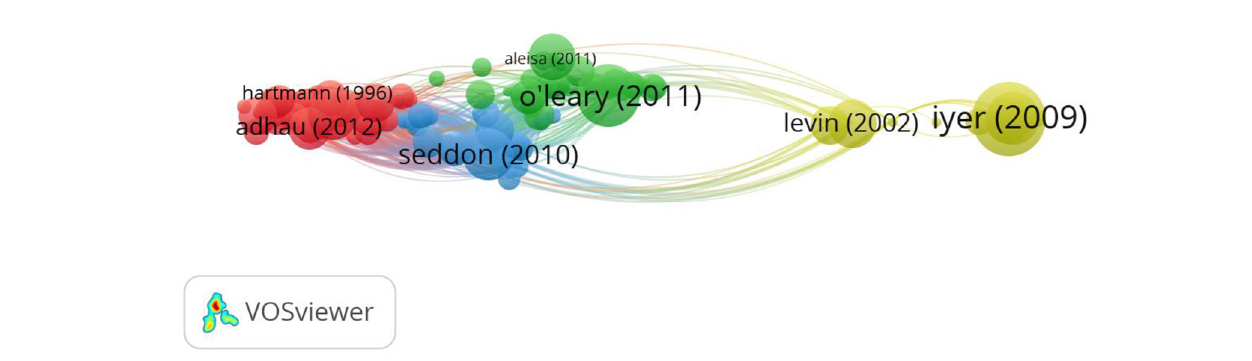
FIGURE5 Bibliographic coupling analysis based on documents.